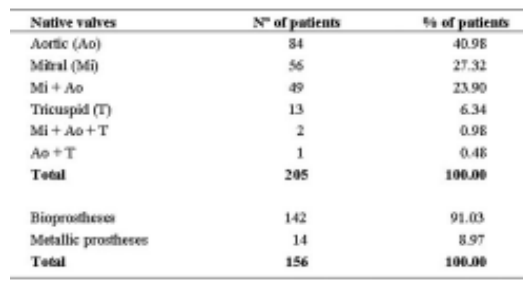
Table 2. Active infectious endocarditis: surgical treatment Affected valves grouped by